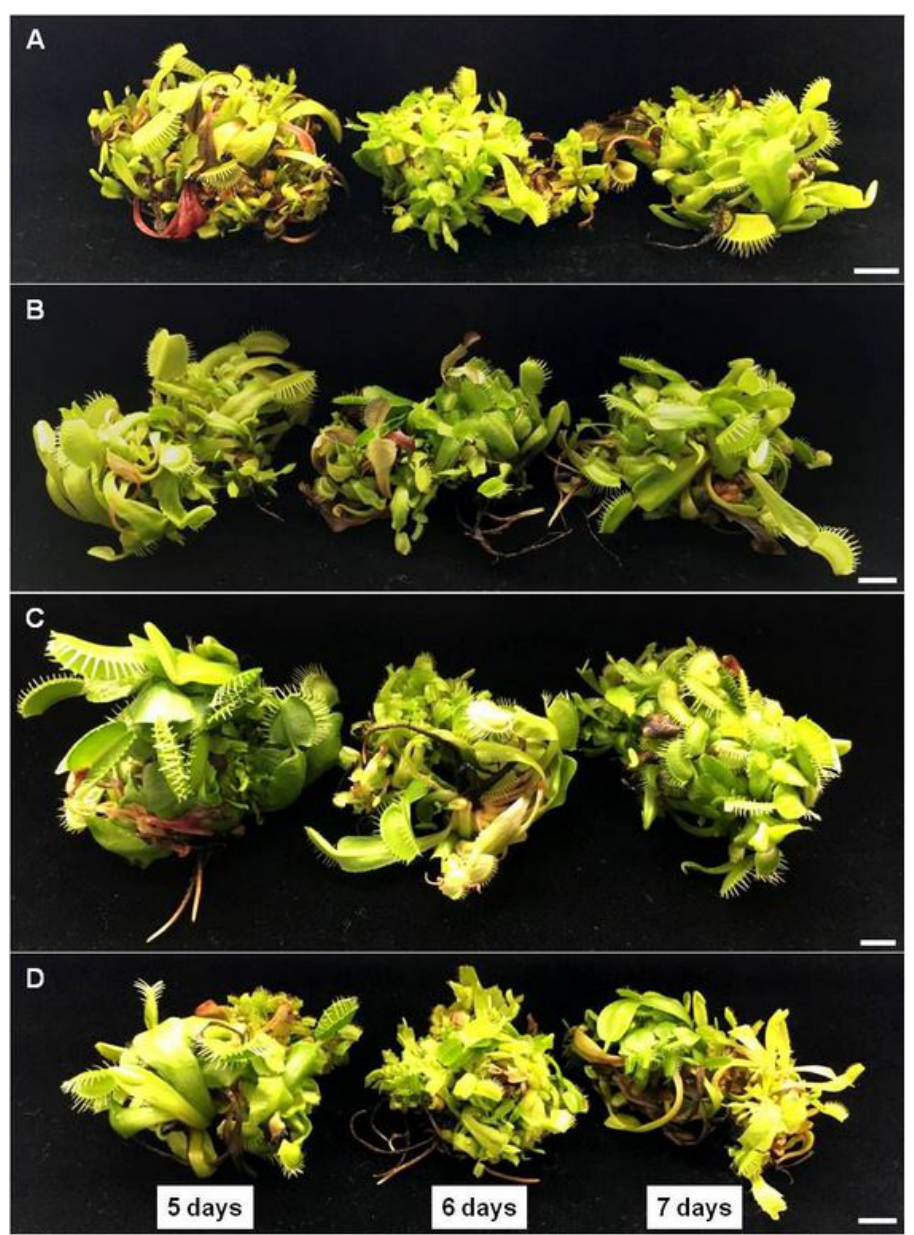
Figure 3. Morphology of Dionaea muscipula plants after 5, 6 and 7 days of elicitation with Cronobacter sakazakii lysate in different concentrations: ( A ) control (0%); ( B ) 1.5%; ( C ) 2.5%; ( D ) 5%; bar—1 cm.